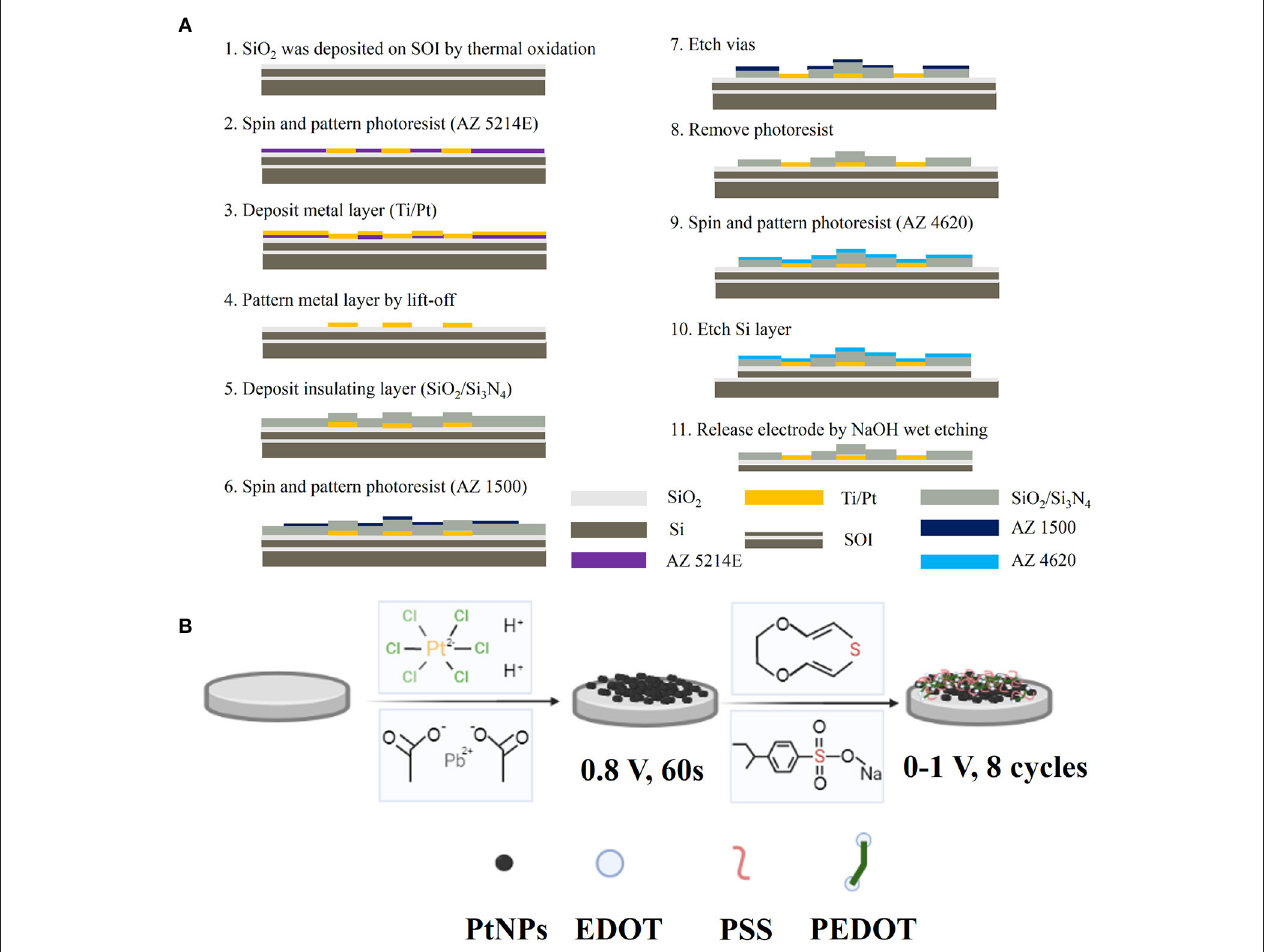
FIGURE 1 | MEA fabrication and modification diagram. (A) Manufacturing process flow of MEA; (B) Schematic diagram of PtNPs/PEDOT:PSS modification